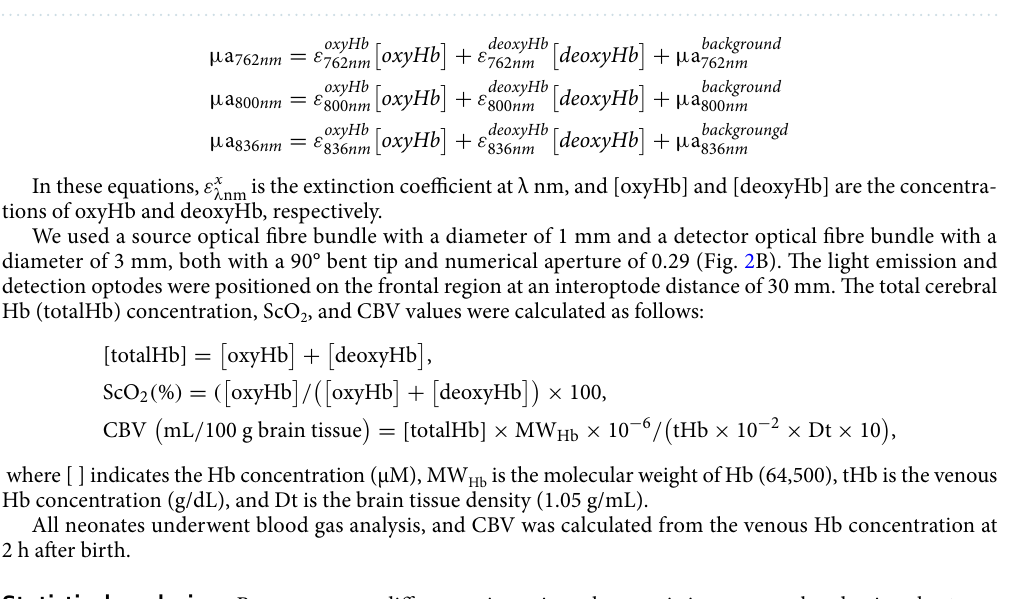
Figure 2. Time-resolved spectroscopy attachment diagram on a simulated infant (mannequin). ( A ) The light source and detection optodes were positioned on the frontal region. ( B ) The interoptode distance was 30 mm. The yellow arrow indicates the optical direction of the 90° bent